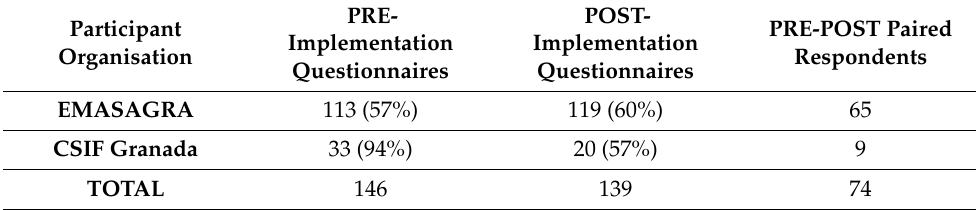
Table 4. Response rates to questionnaires and paired respondents.